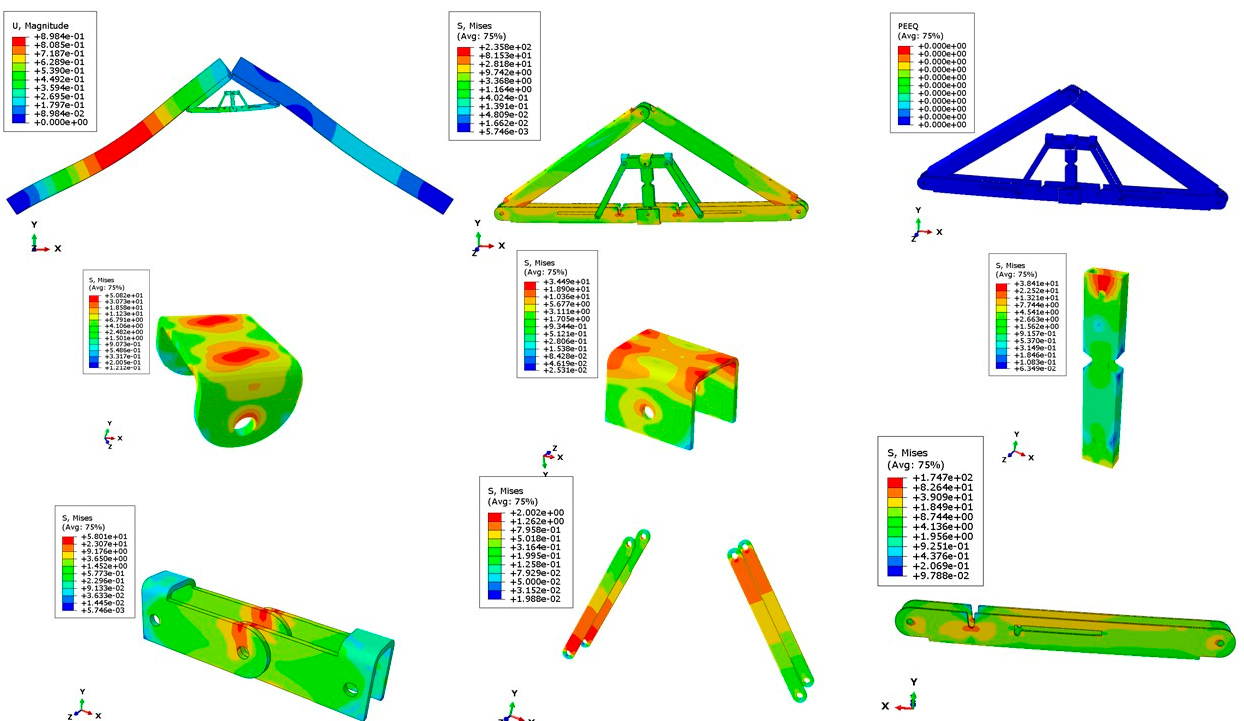
Figure 32. Stress (MPa) in different parts for partial snow load case (specified snow load of 2.25 kPa).